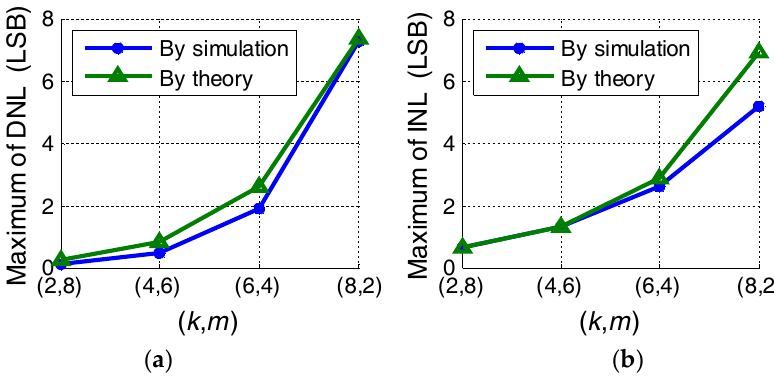
Figure 5. A comparison between the maximum nonlinearity from the numerical simulation and theoretical prediction equation. ( a ) DNL, ( b ) INL.